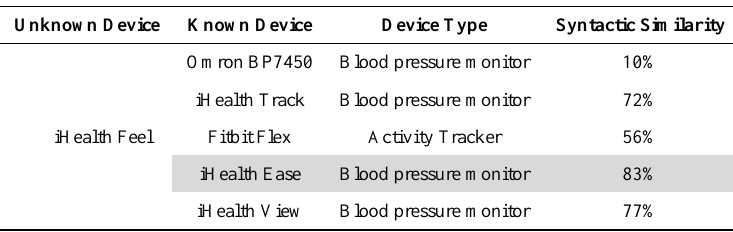
Table 4. Connected IoMT device specifications